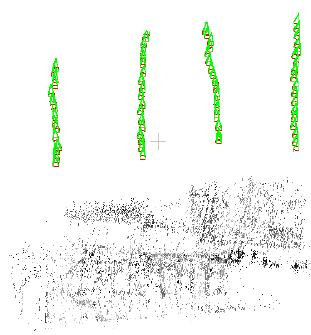
Figure 5. Results of bundle adjustment